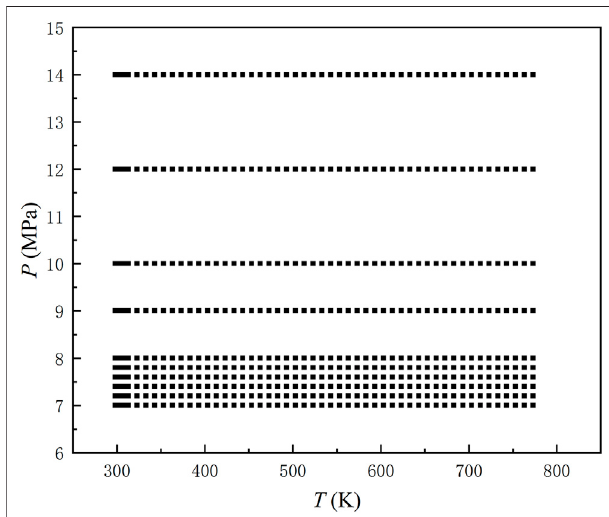
FIGURE 2 | Distribution of experimental data points.